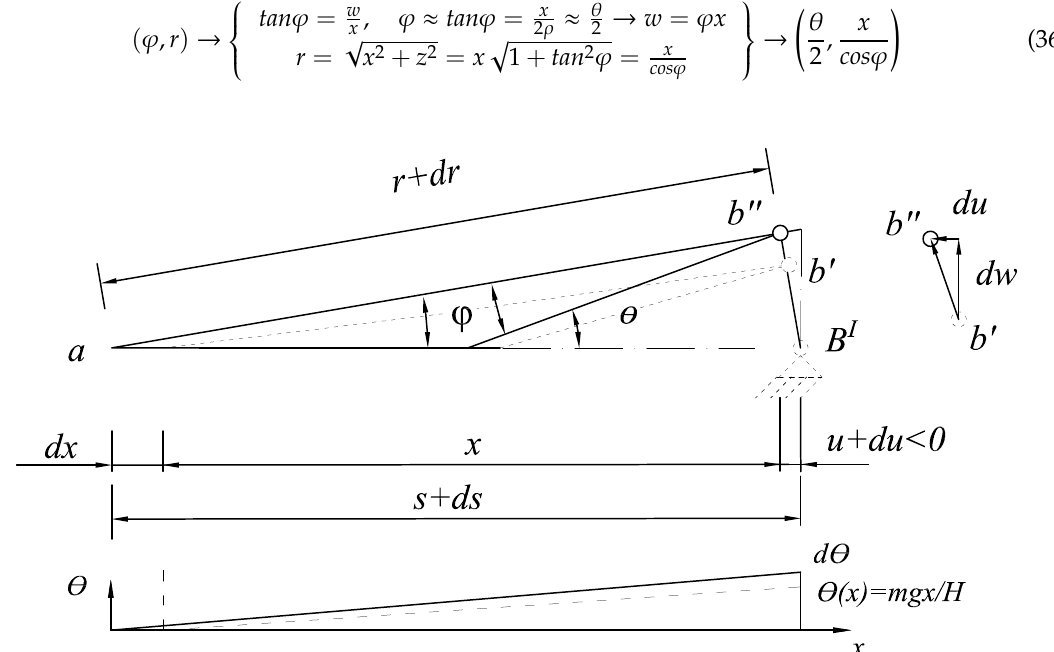
Figure 5. Polar coordinates for the right segment of the parabola, a-b (Phase II). Radius aB I .